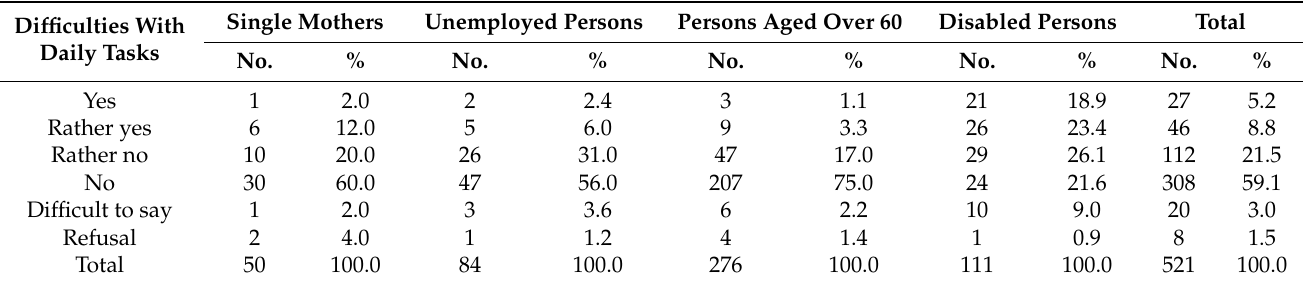
Table 6. Difficulties with daily tasks by social status of the respondents ( n =